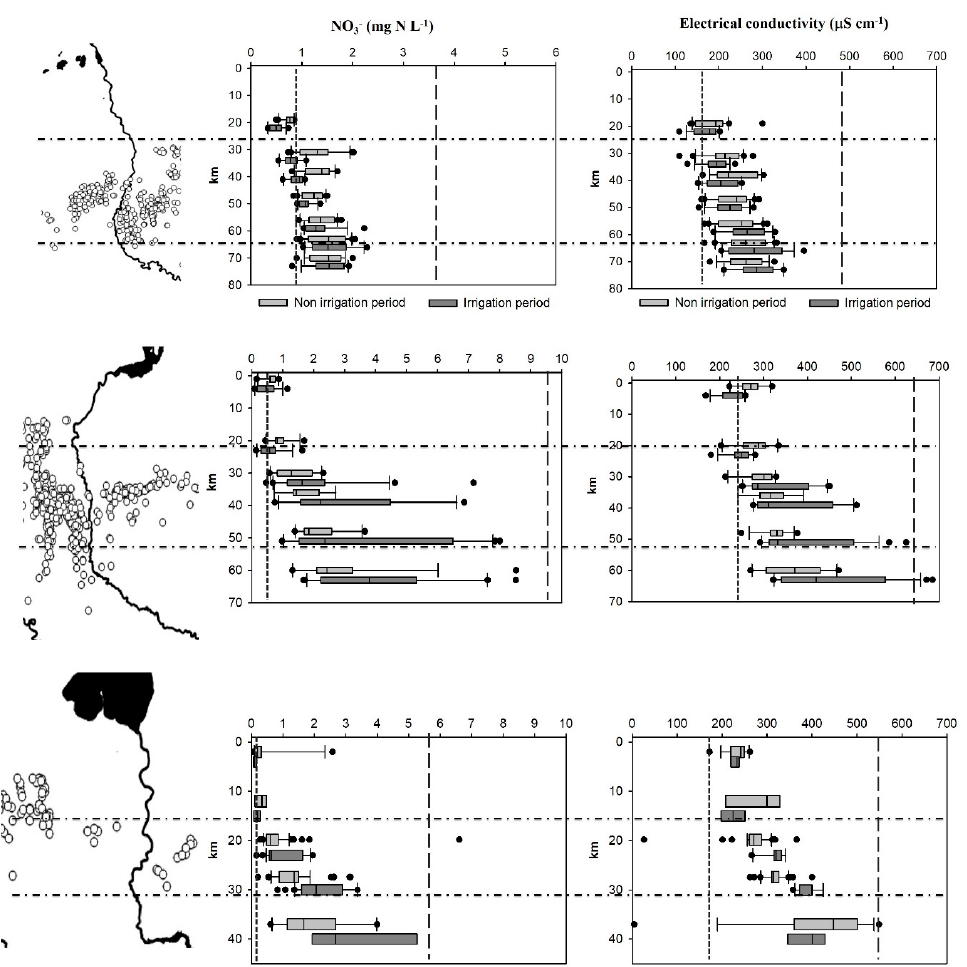
Figure 5. The image on the left shows the three river reaches, from their origins to the southern portion of the spring belt area. From the top to the bottom the Adda, Oglio, and Mincio rivers are reported. The horizontal lines roughly indicate the width of the spring belt area which is crossed by the three rivers, while white dots indicate all counted springs. The graphs show the upstream–downstream variation of NO 3 − concentration and electrical conductivity along the considered stretches in the irrigation and non-irrigation periods. Data are reported as boxplots, as they include multiple observations in different years (2006–2014). Vertical lines in each graph represent, for a given study area, the average NO 3 − concentration and specific conductivity of Lakes Como, Iseo, and Garda ( on the left ) and of the river adjacent springs ( on the right ).